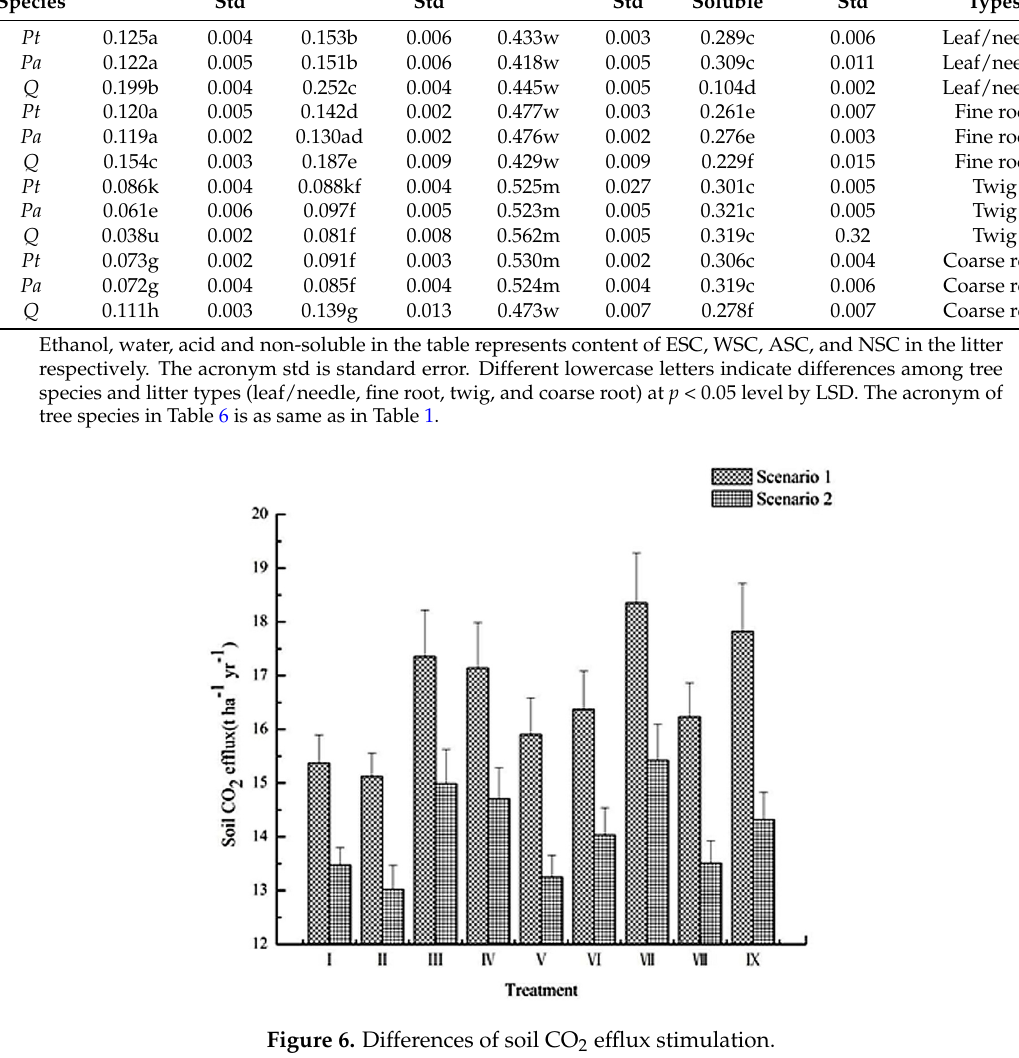
Figure 6. Differences of soil CO 2 efflux stimulation.